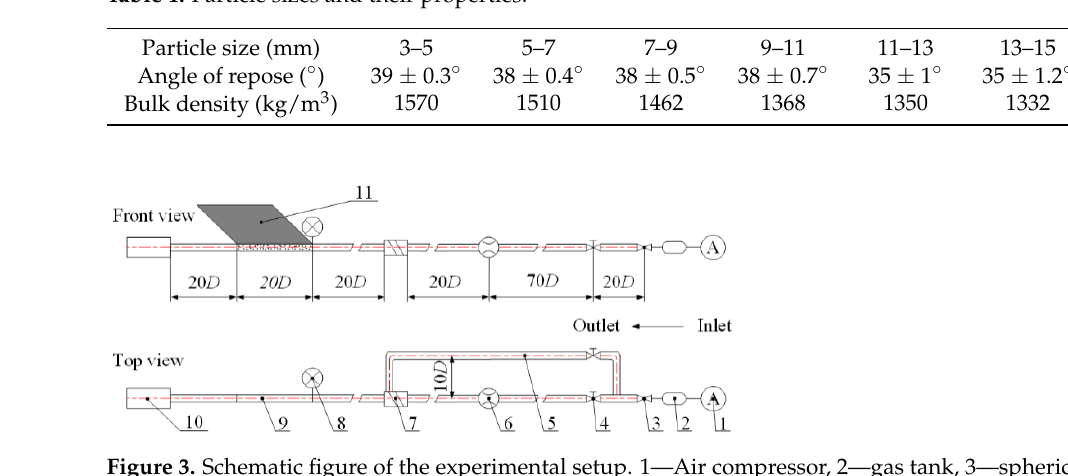
Figure 3. Schematic figure of the experimental setup. 1 — Air compressor, 2 — gas tank, 3 — spherical valve, 4 — spherical value, 5 — tangential flow, 6 — flowmeter, 7 — swirling generator, 8 — pressure sensor, 9 — acrylic transparent tube, 10 — receiving device, 11 — high speed camera.